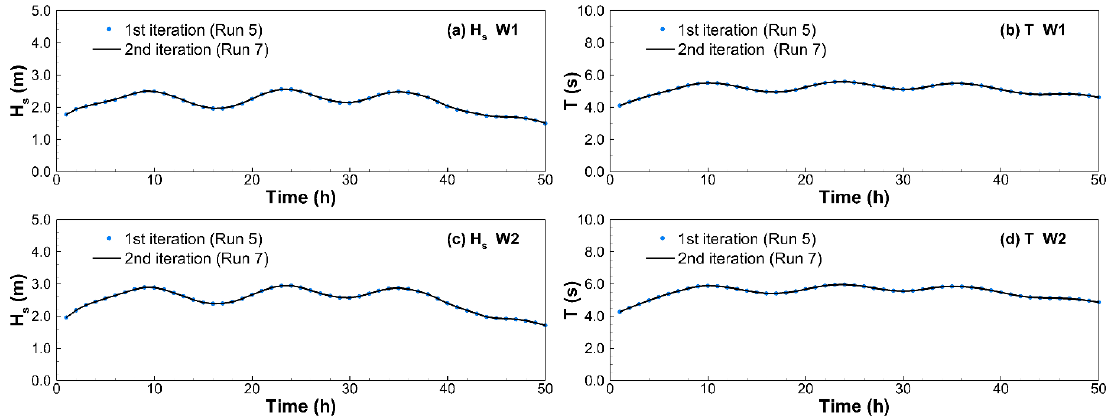
Figure 3. Validation of the wave model (run 5). ( a ) Significant wave height ( H s ) at W1. ( b ) Significant wave period ( T ) at W1. ( c ) Significant wave height at W2. ( d ) Significant wave period at W2.